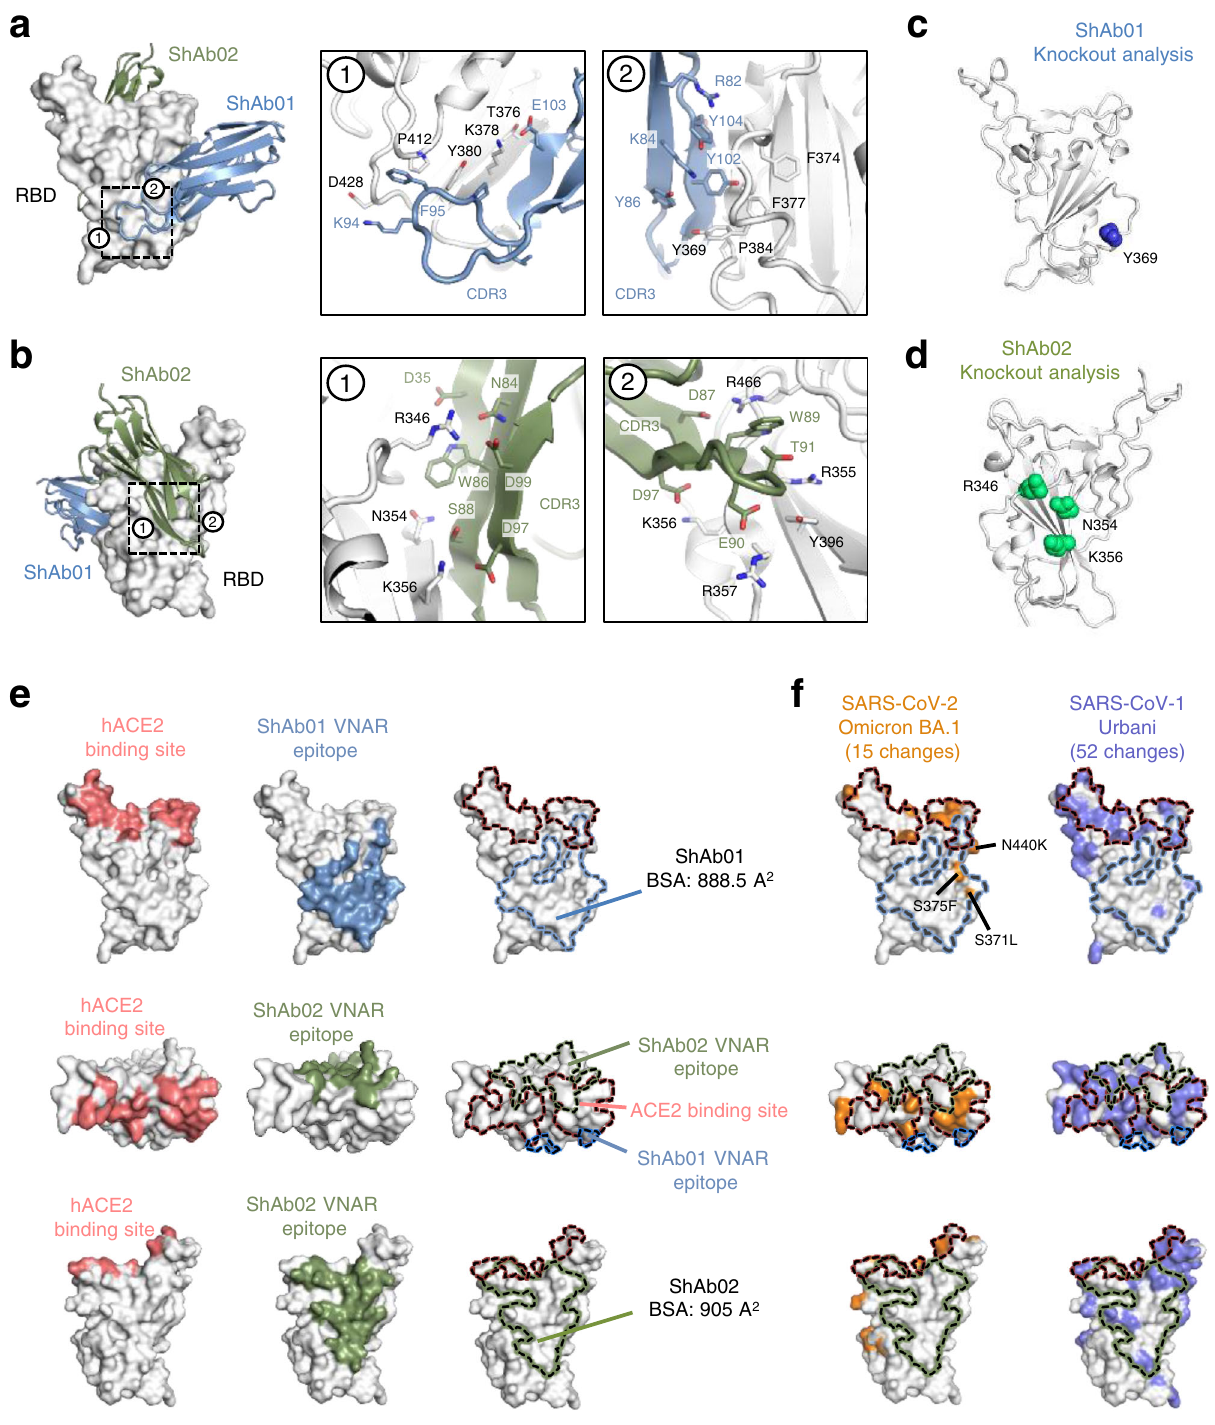
Fig.4|StructuralanalysisoftheinteractionofShAb01andShAb02withSARS- CoV-2 RBD. a Crystal structure of ShAb01 and ShAb02 VNARs in complex with SARS-CoV-2RBD.ThecriticalresiduesofShAb01-RBDinteractionareshownintwo zoom-inpanels,withextensivecontactsmadebytheCDR3loop. b Crystalstructure of the ShAb01-ShAb02-RBD complex rotated from a . The critical residues of ShAb02-RBDinteraction are shownin two zoom-inpanels, with extensive contacts made by the VNAR CDR loops 1 – 3. c Epitope mapping by alanine mutagenesis scanning analysis identi fi ed SARS-CoV-2 RBD residue Y369 as a critical contact residue for ShAb01 binding. d Epitope mapping by alanine mutagenesis scanning